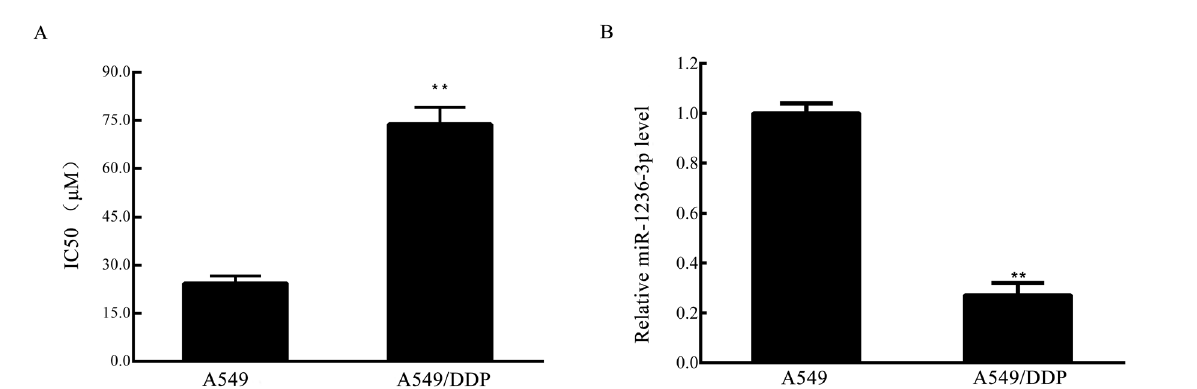
Figure 2: IC50 of DDP and the expression level of miR-1236-3p in A549 and A549/DDP cells. (A) The concentration of 20 μg/ml-DDP was added to verify the IC50 values in A549 and A549/DDP cells after 24 h exposure. (B) The expression level of miR-1236-3p in A549 and A549/DDP cells was measured by RT-qPCR assay. **P<0.01, A549/DDP vs A549 group. A549, lung cancer cell line; A549/DDP, human lung adenocarcinoma drug-resistant cell line; miR-1236-3p, microRNA-1236-3p mimics-transfected cells; IC50, the half maximal inhibitory concentration.